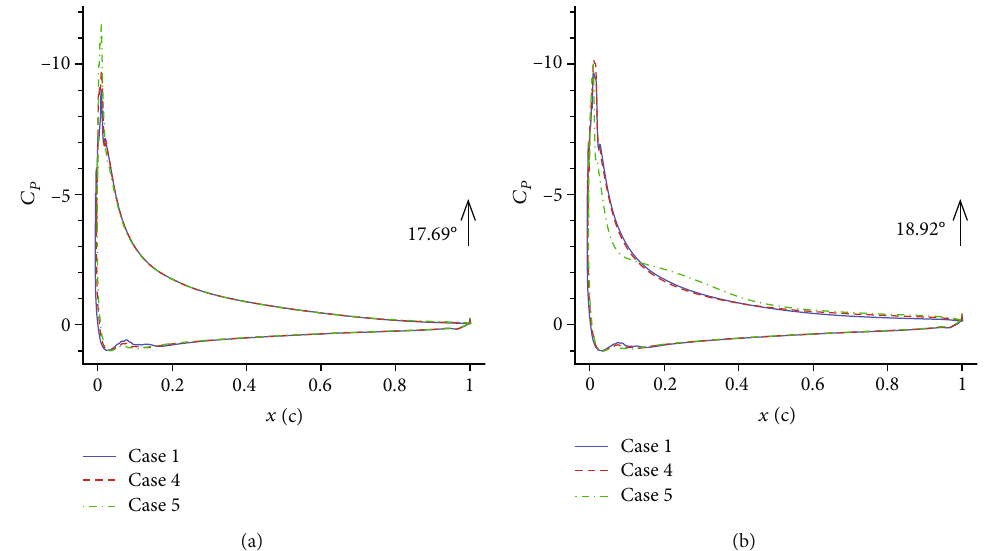
Figure 26: Comparison of pressure coe ffi cient distributions at angles of attack of 17.69 and 19.32deg upstroke for Cases 1, 4, and